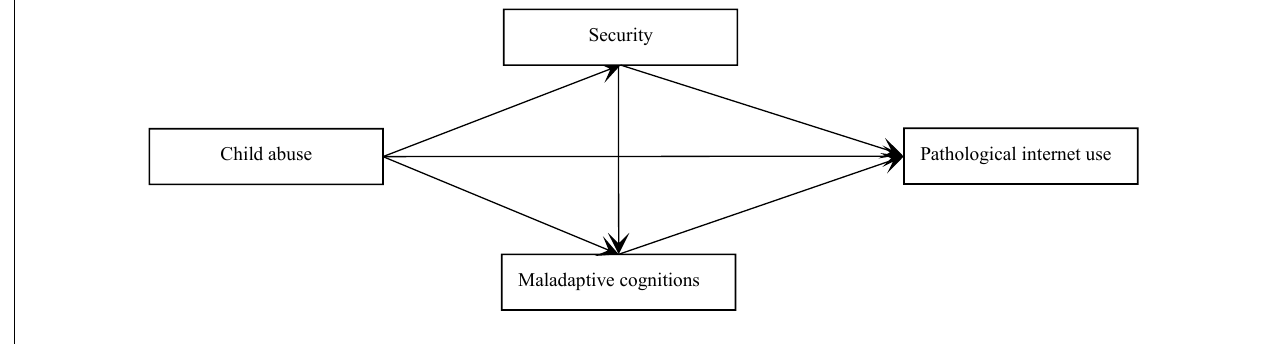
FIGURE 1 | Proposed